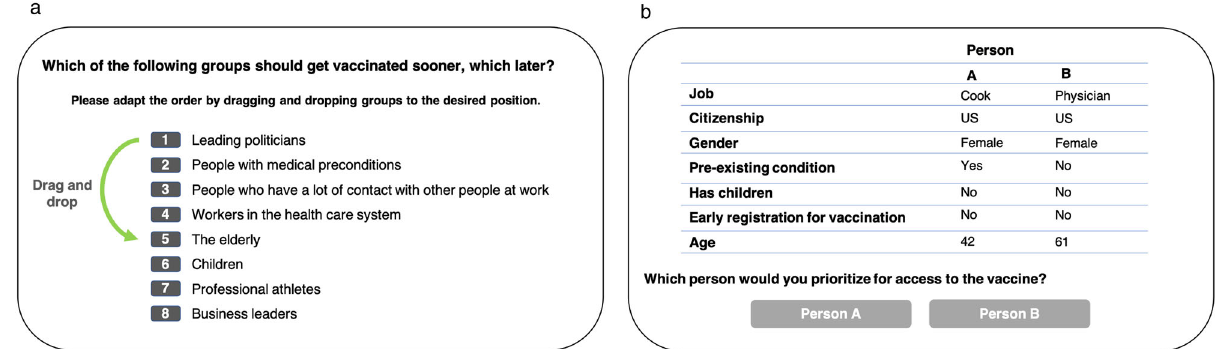
Fig. 1 Illustration of ranking task and conjoint experiment. a : Rankings of preferred priorities. b Example setup of forced choice conjoint experiment. HUMANITIES AND SOCIAL SCIENCES COMMUNICATIONS| (2022) 9:439